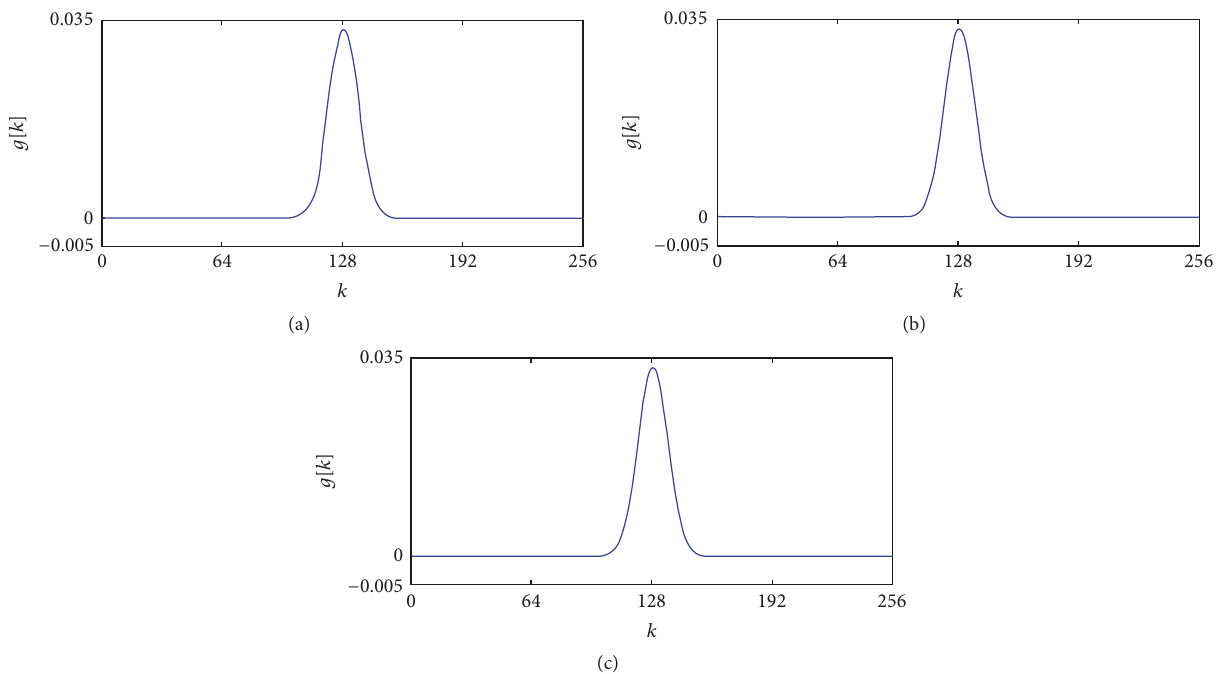
Figure 4: Analysis windows 𝑔[𝑘] in the oversampling case ( Δ𝑀 = 32 , Δ𝜔 = 4 , 𝛽 = 8 ) obtained by the proposed method [9,